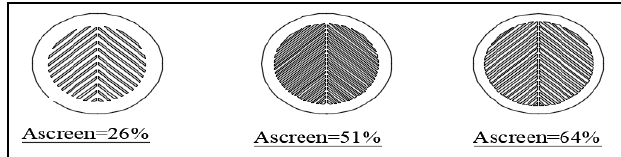
Figure 5. Sketch of different inlet area of grate type 4.